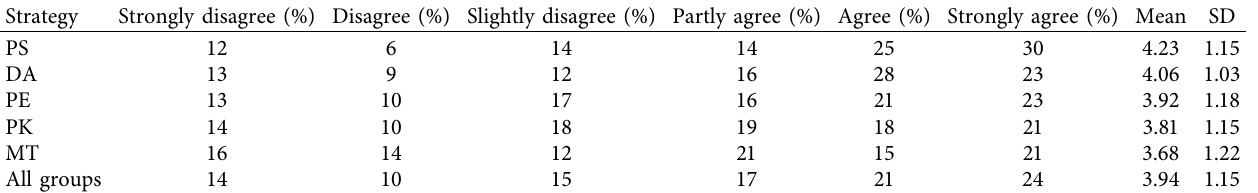
Table 2: Distribution of mean scores and SD of all participants’ responses to MLCS (subscale) ( N � 353).